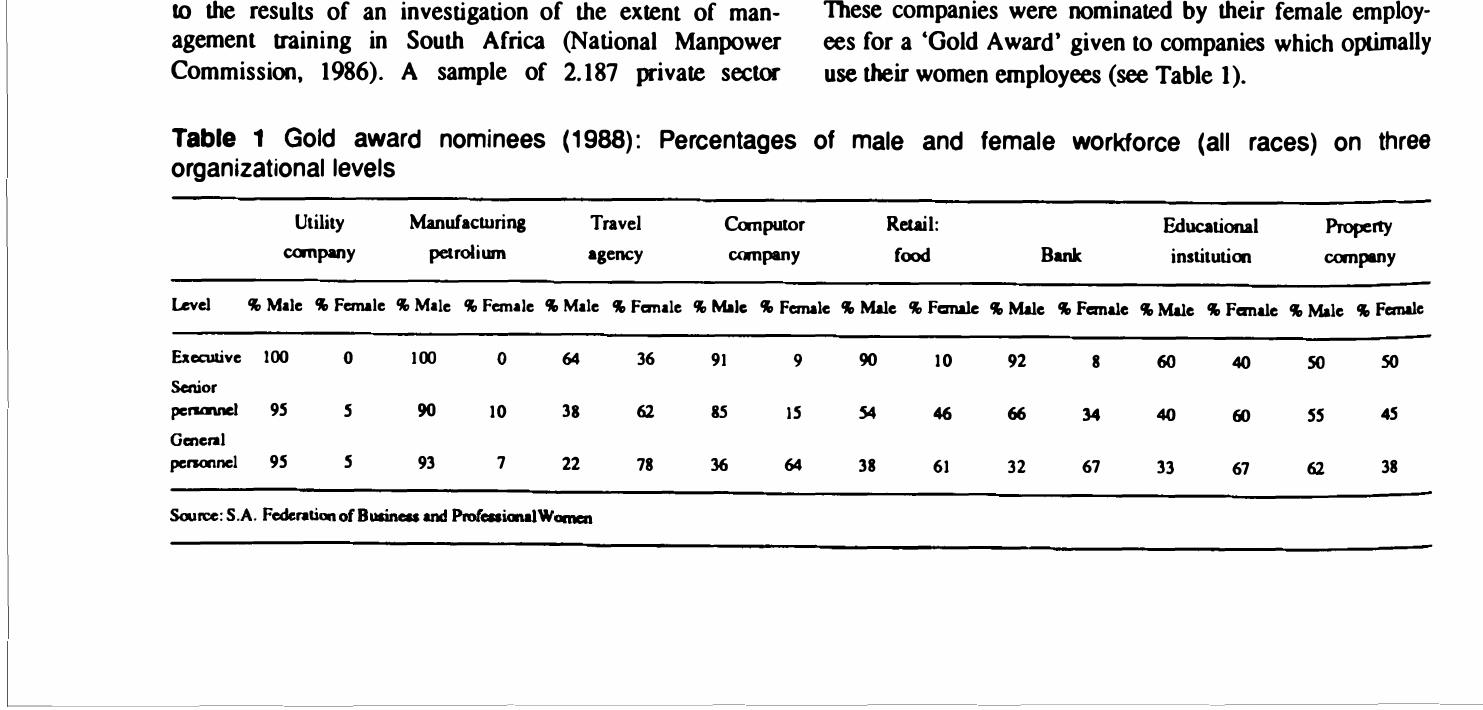
1 Gold award nominees (1988): Percentages of male and female workforce (all races) on three organizational